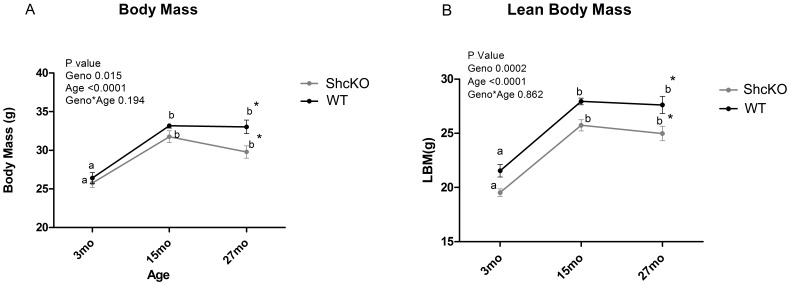
Body weight and fat free mass in ShcKO and wild-type (WT) mice.Mean (±SEM) body weight (A) and fat free mass measured in 3, 15 and 27 month old animals housed at 22°C. Letters that differ indicate significance within genotype between age, ANOVA bonferroni corrected P<0.0001; *Difference between genotypes within age P<0.05. ShcKO = p66Shc(−/−) mice, Geno = genotype, mo = months.